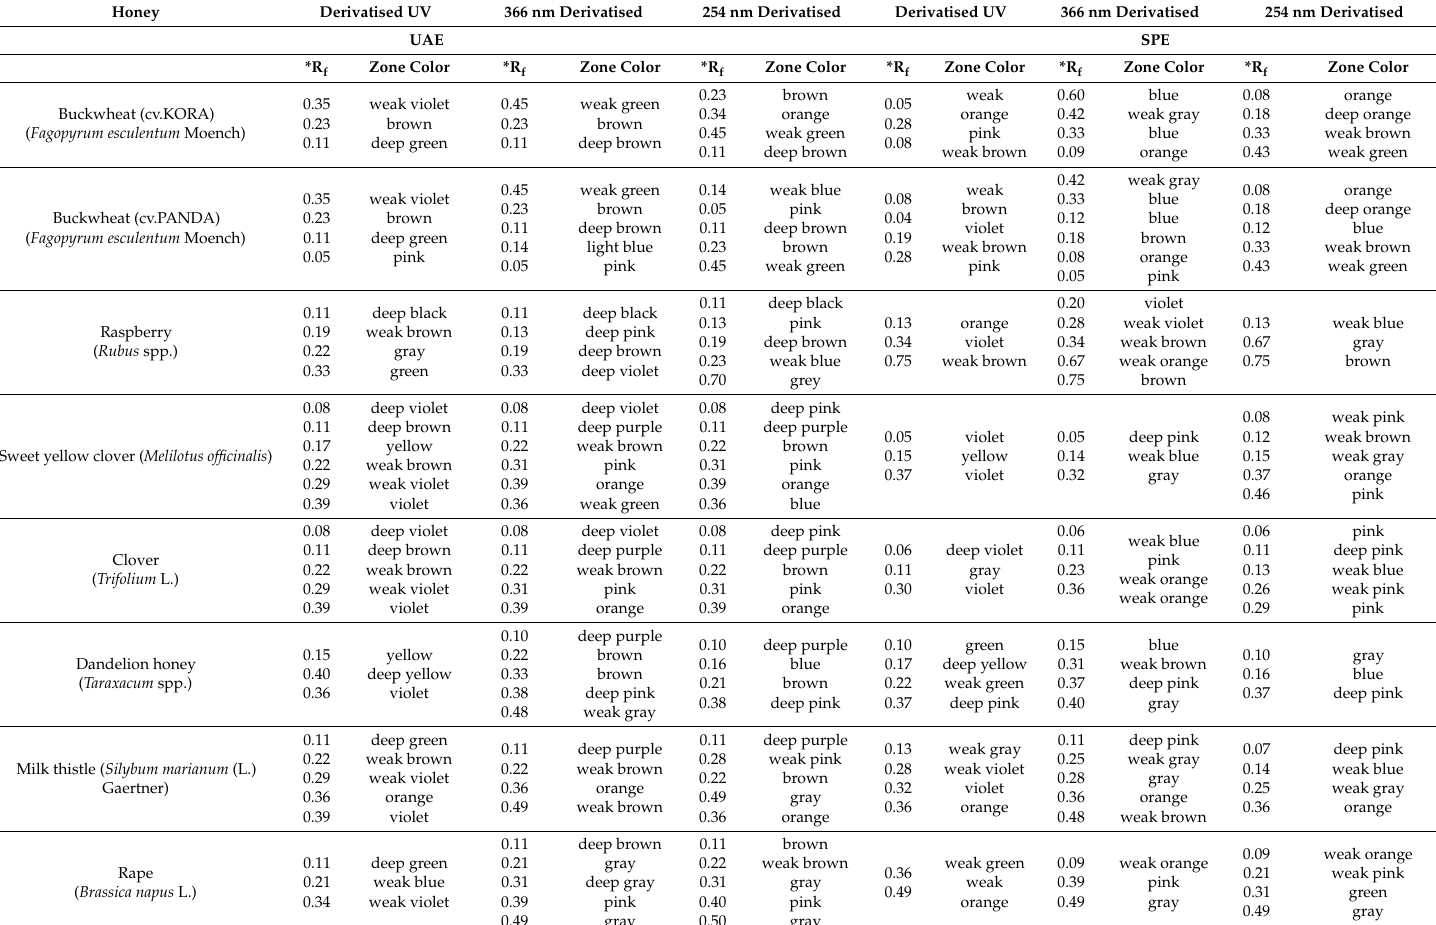
Table 1. Characteristic Rf values for tested